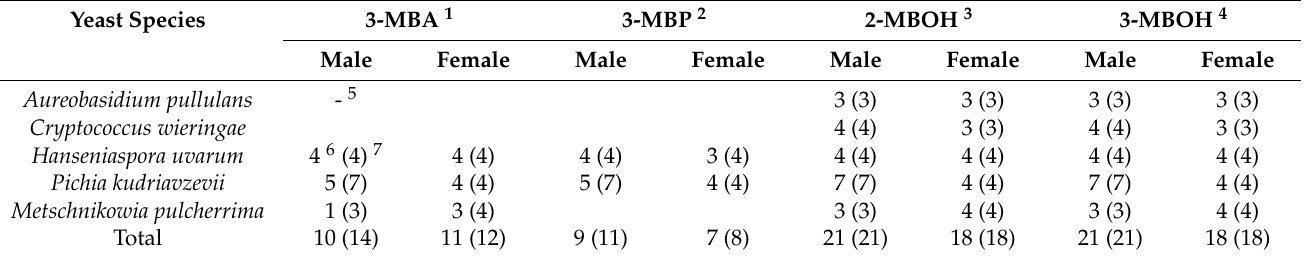
Figure 4. GC-EAD response of male and female Rhagoletis cerasi to headspace volatiles of Hanseniaspora uvarum yeast. FID, flame ionisation detector; EAD, electroantennographic detector; DB-Wax Table 2. Electroantennographic responses of R. cerasi flies to volatiles present in the headspace of five yeast species.